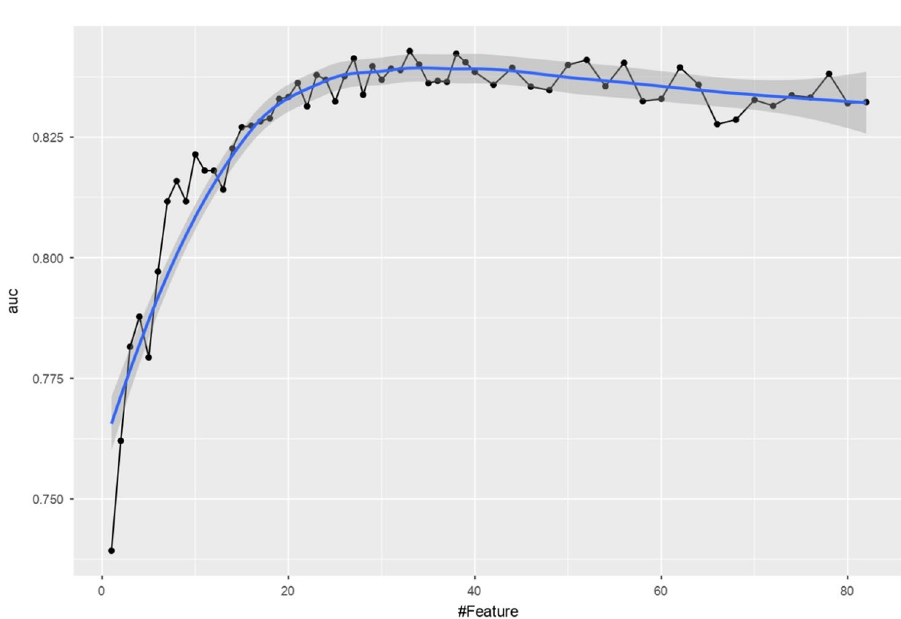
Figure 4. AUC for XGBoost during each